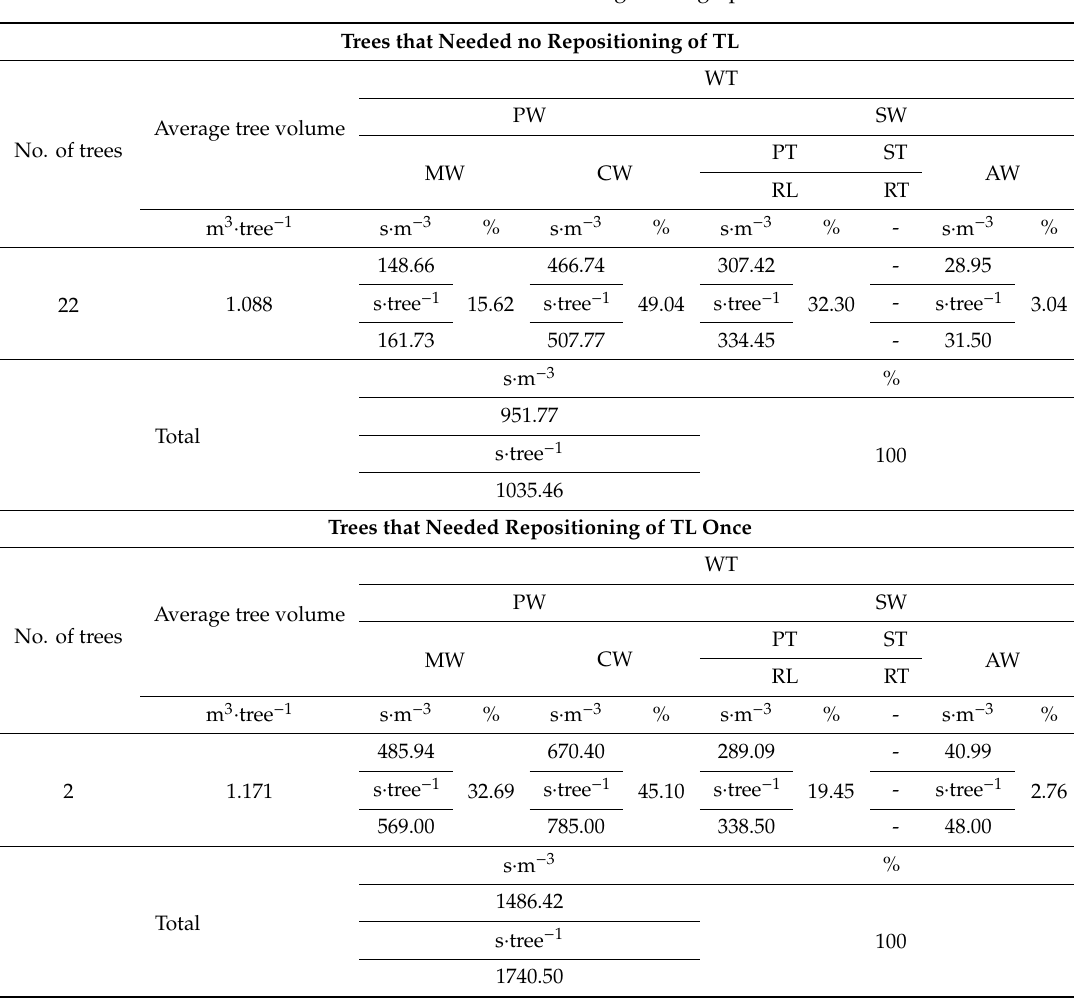
Table 5. WT structure in the felling of hung up